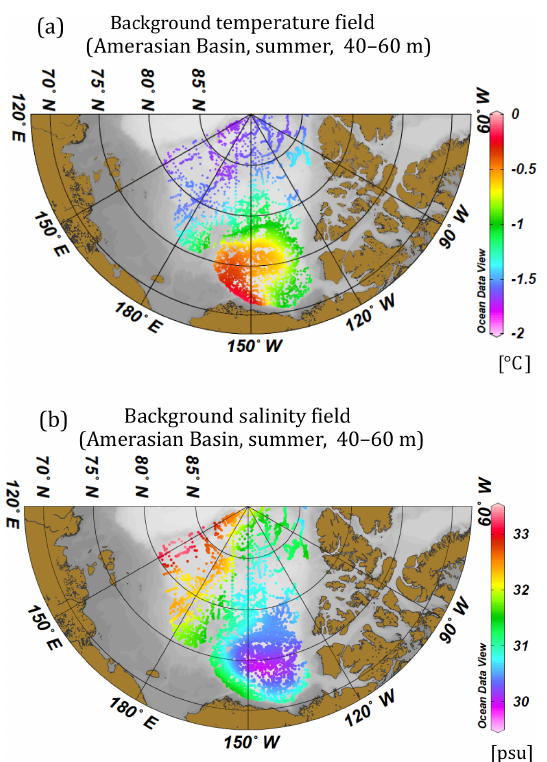
Figure 7. Background mean field of (a) temperature and (b) salin- ity (40–60m depth range) in summer (July–September) obtained by Gaussian filtering with the e -folding scales shown in Fig. 6. A verti- cal filter (average of three adjacent layers) is applied to the e -folding scales before the application in order to obtain a smooth transition of the filtering scale in the vertical direction. The background field is calculated only at the locations where data exist in the Amerasian Basin (bottom depth >